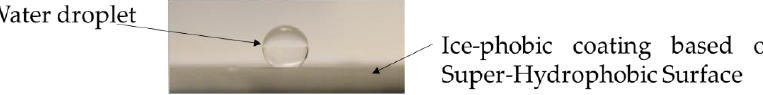
Figure 6. A photograph of an interface between the ice-phobic coating and a water droplet.